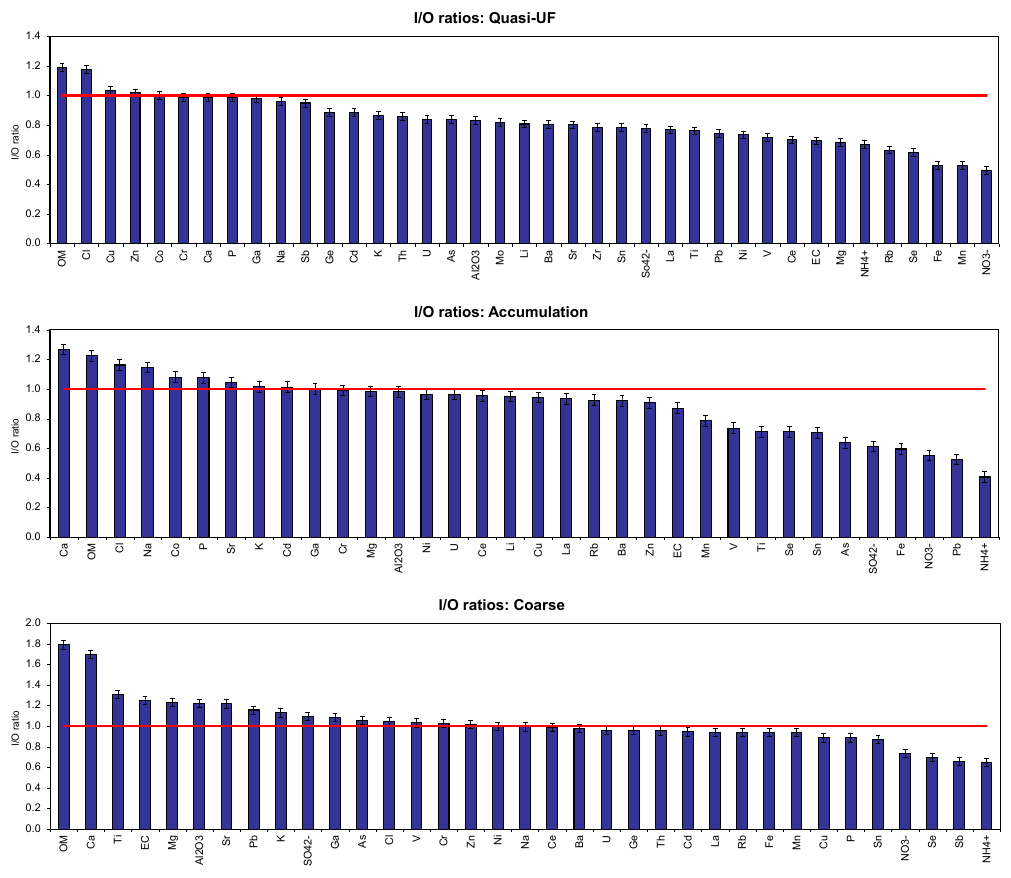
Fig. 5. Mean I/O ratios for quasi-UF, accumulation and coarse mode particles, with standard errors.4